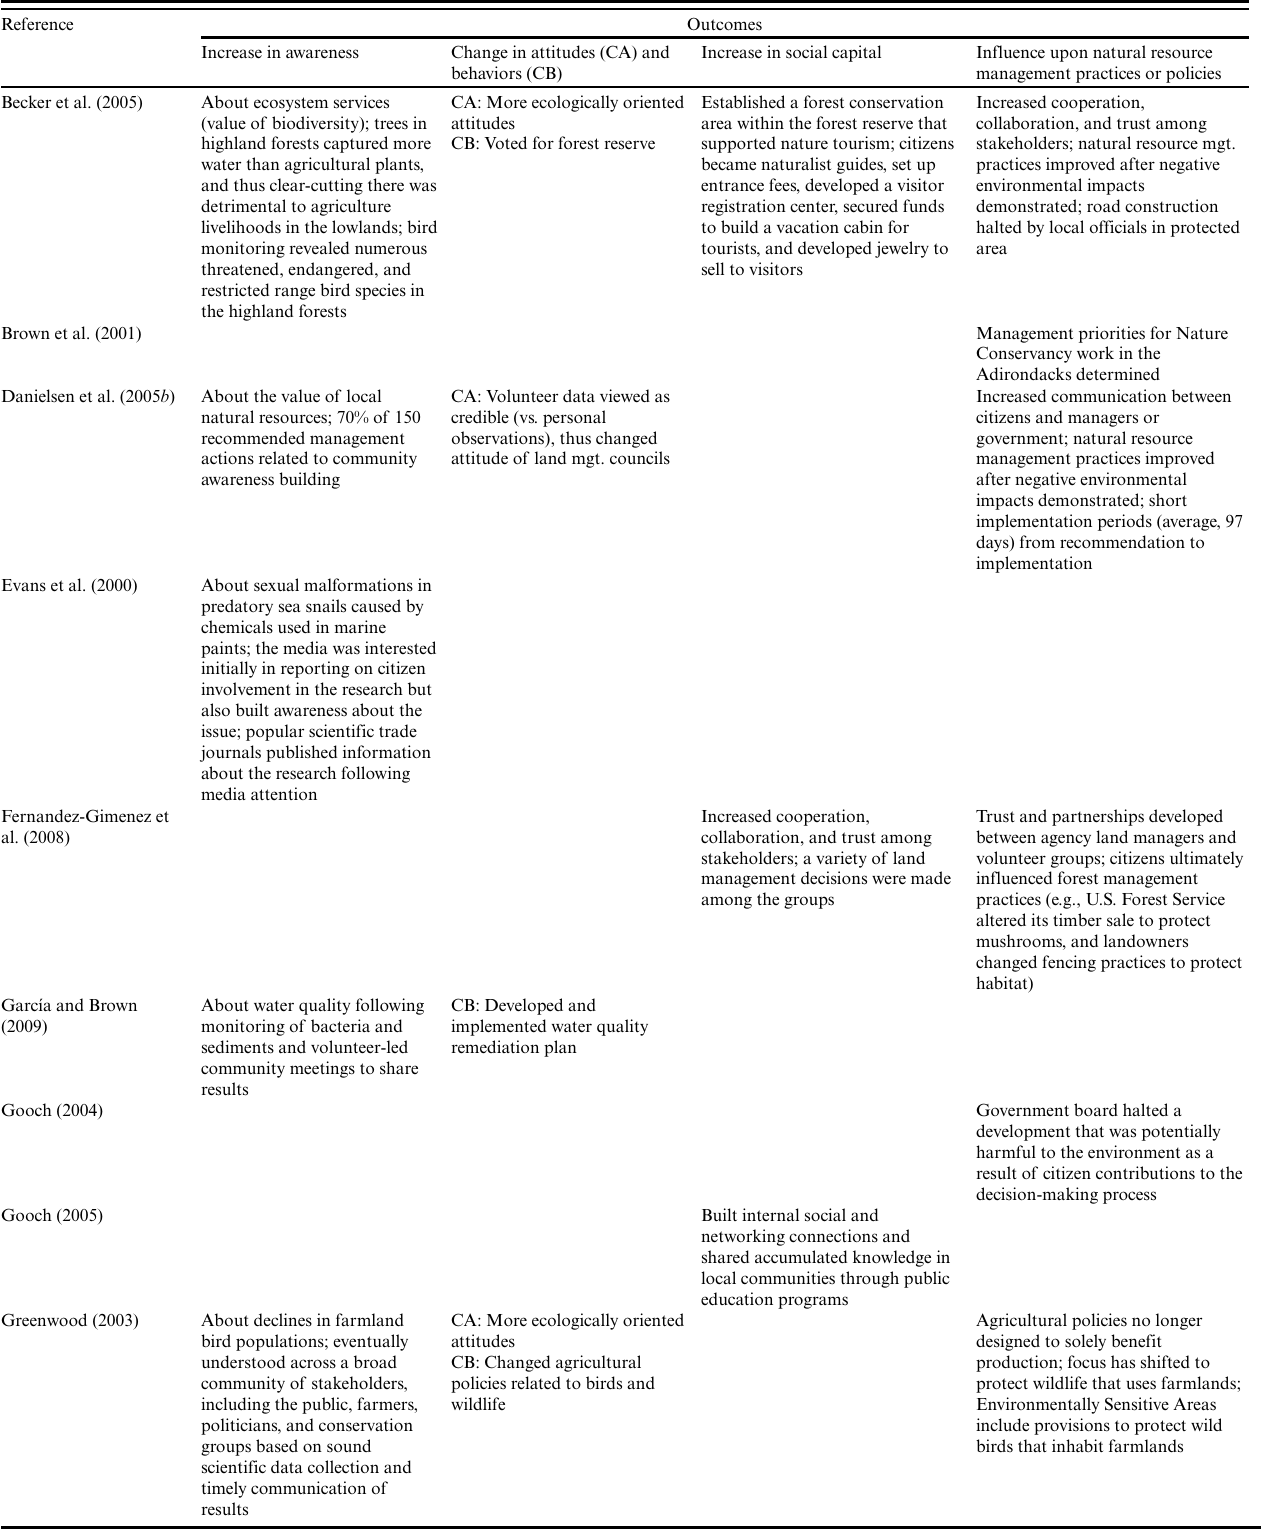
Table 5 . Outcomes of volunteer environmental monitoring for communities reported in peer-reviewed journals through 2012.